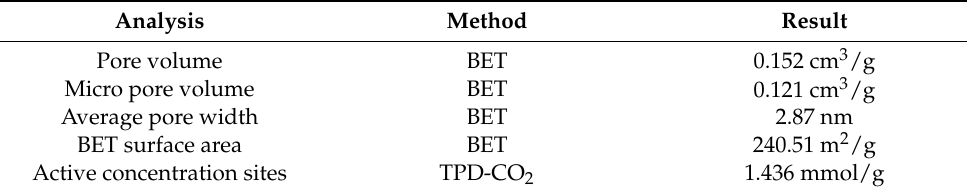
Table 2. Characterization of catalyst (CaO/AC) with